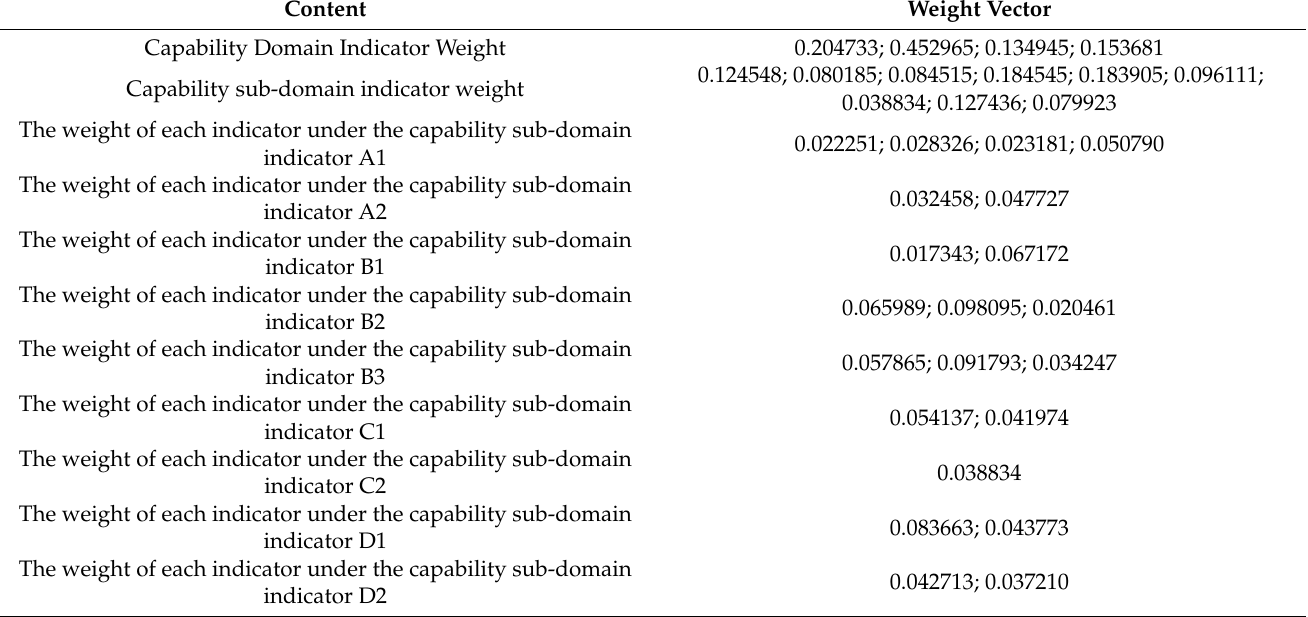
Table 3. The weight of the maturity index of intelligent manufacturing capability of chair industry enterprises.